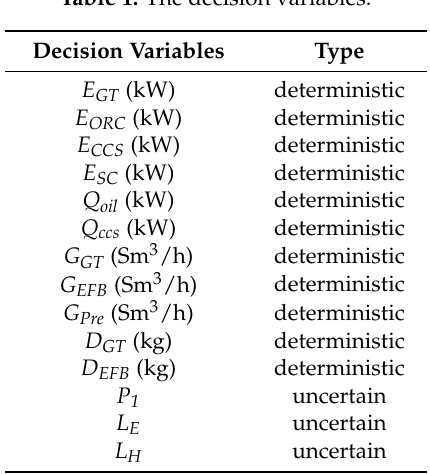
Table 1. The decision